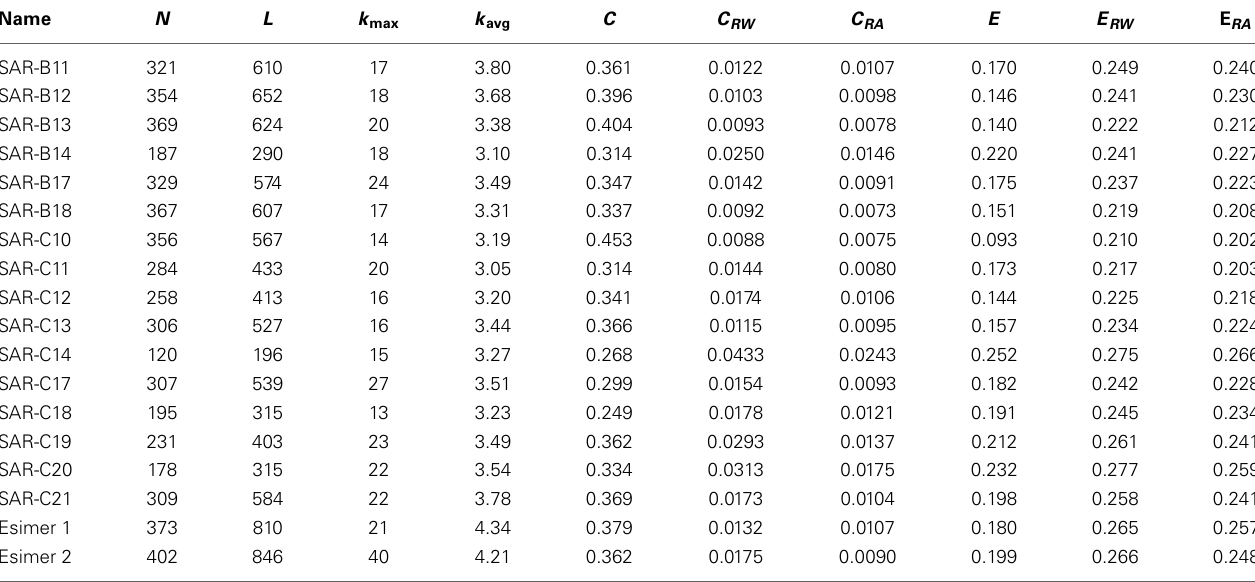
Table 1 | Network properties for different samples of SAR and optical (Esimer) images.